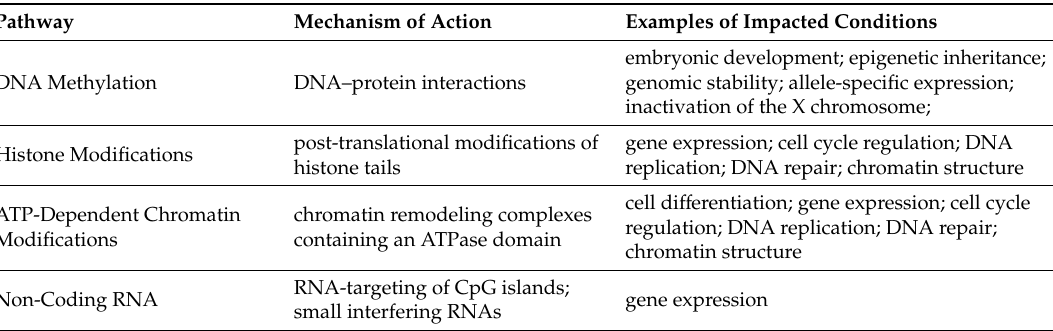
Table 1. Key pathways of epigenetic